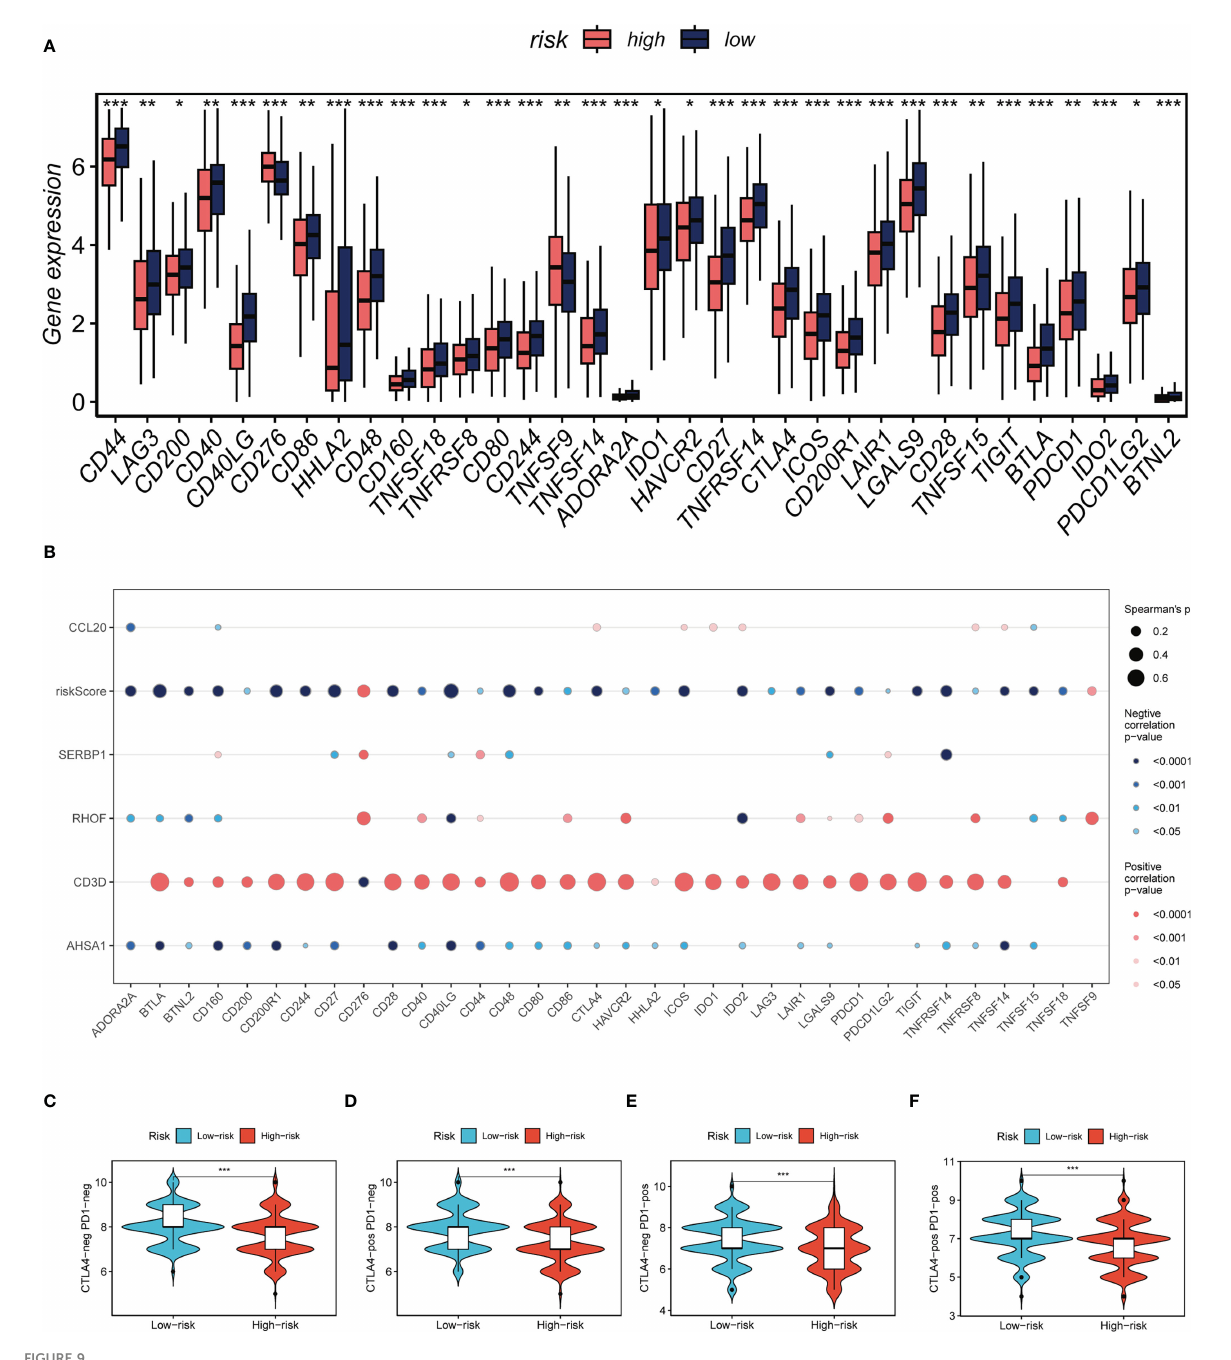
FIGURE 9 Immune checkpoint and TCIA analysis. (A) A box plot showed that differences in immune checkpoint gene expression between high- and low-risk groups. (B) Correlation between model genes and immune checkpoint. (C-F) The low-risk group has signi fi cantly greater IPS, IPS-CTLA4-neg-PD-1- neg, IPS-CTLA4-pos-PD-1-neg, IPS-CTLA4-neg-PD-1-pos, and IPS-CTLA4-pos-PD-1-pos. Note: * P < 0.05, ** P < 0.01, *** P <